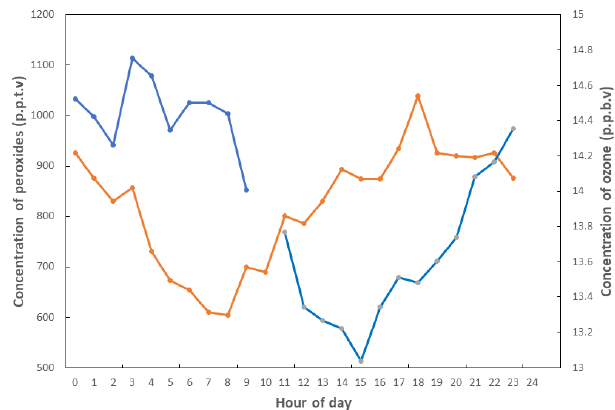
Figure 8. Average diurnal cycles of peroxide (orange line) and ozone (blue line) in baseline (low NO x ) air at Cape Grim (Tasma- nia, Australia) in January 1992. Adapted from Ayers et al. (1992).